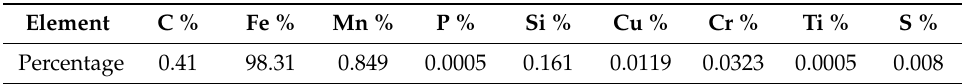
Table 1. Chemical composition of AISI 1045.